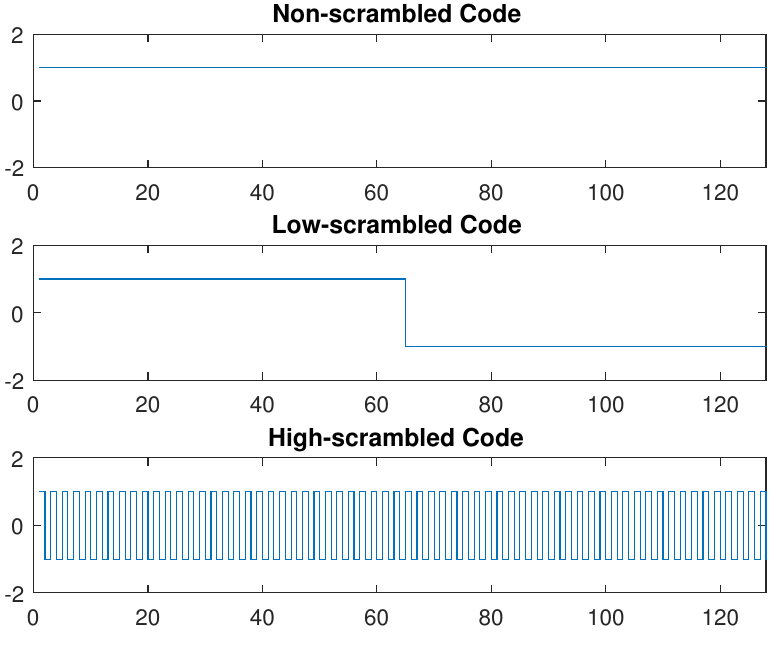
Figure 6. Walsh-Hadamard spreading. codes